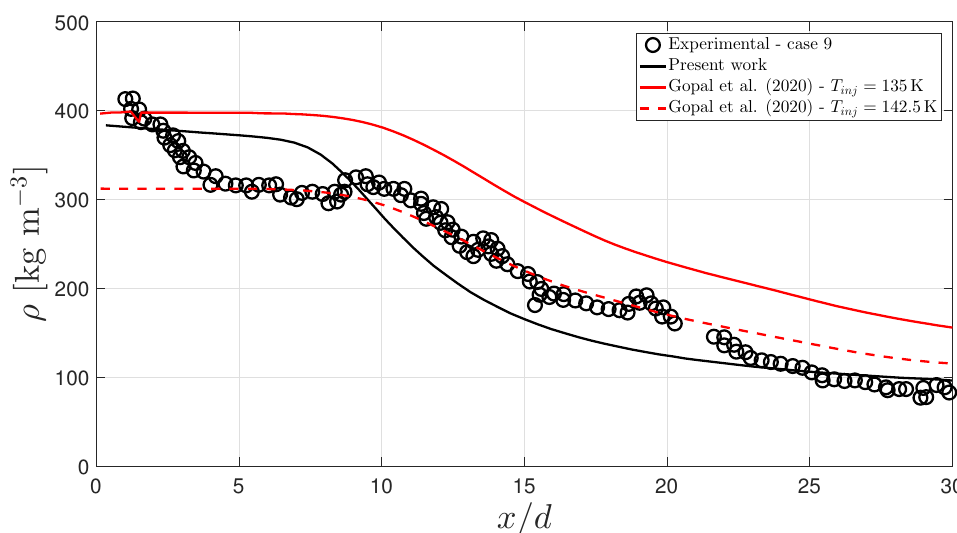
Figure 12. Comparison of the axial density distribution of case 9 with studies in the literature